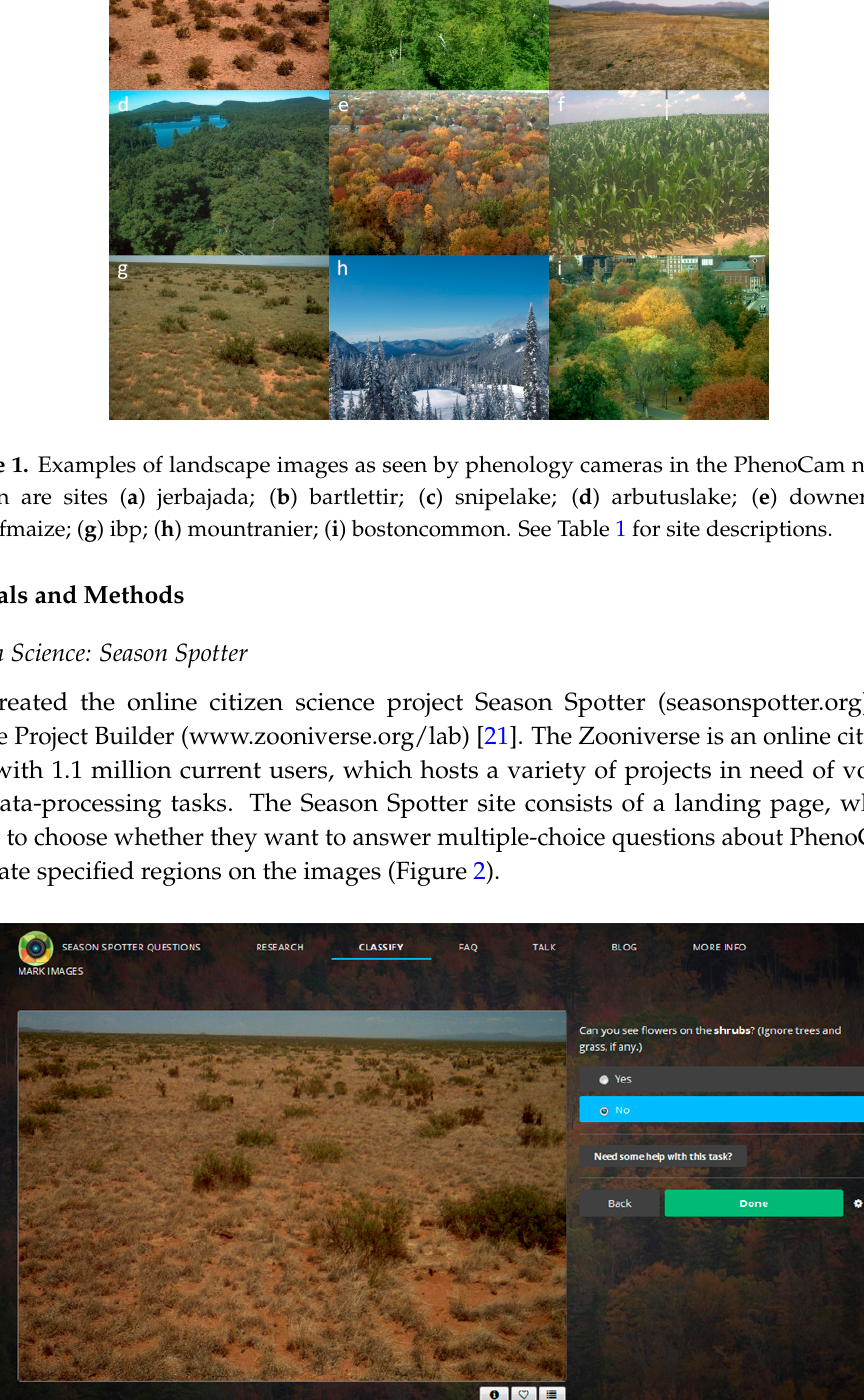
Figure 2. The Season Spotter user interface.